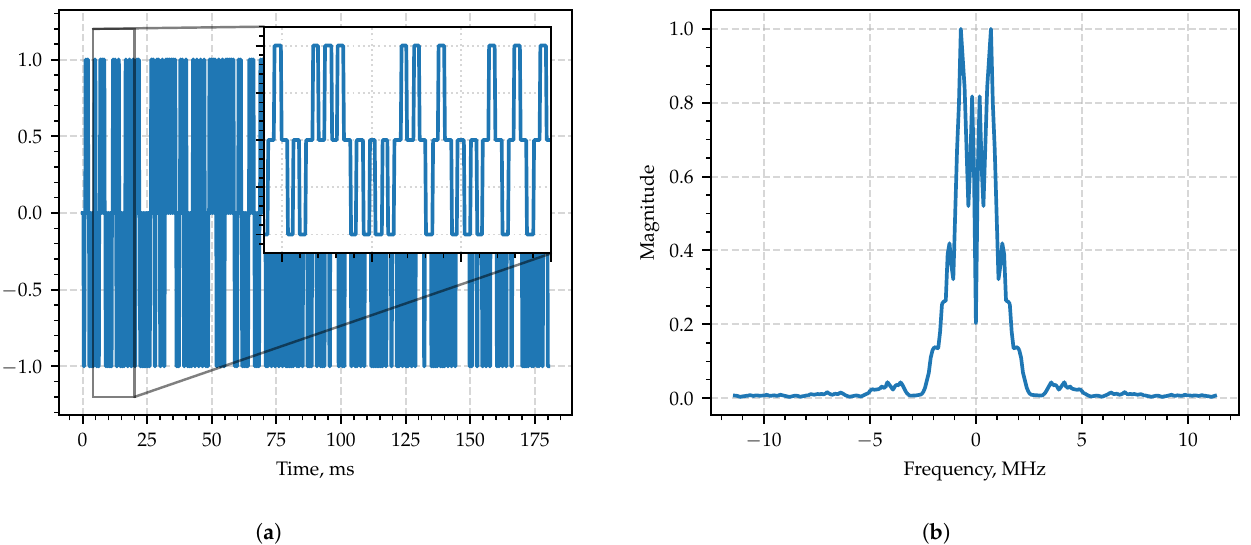
Figure 8. Fragment of the second example—PAM signal x ( t ) in the time domain ( a ) and in the frequency domain ( b